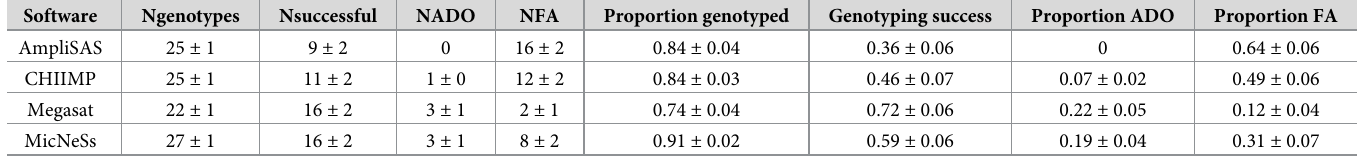
Table 3. Genotyping error rates among software packages using a minimum read depth of 16. Proportion genotyped , the number of genotypes estimated by each soft- ware ( N genotypes ) divided by the total number of reference genotypes per locus across all replicates and samples. Genotyping success , the number of genotypes that coincide with the reference ( N ) divided by the total number of genotypes estimated by the software per locus across all replicates and samples ( N successful the number of heterozygote genotypes for which only one of the two alleles could be genotyped ( N ADO ) divided by the number of heterozygote genotypes in the reference. Proportion FA , the number of genotypes including a false allele ( N FA ) divided by the total number of reference genotypes. Values are shown as mean ± standard error per